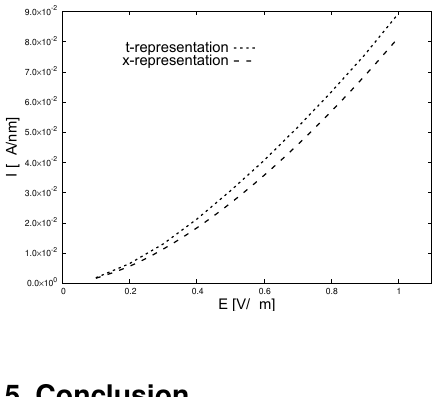
Figure 3. Comparison of calculated current density values for a sample with L = 100 nm in the range of electrical field strengths E